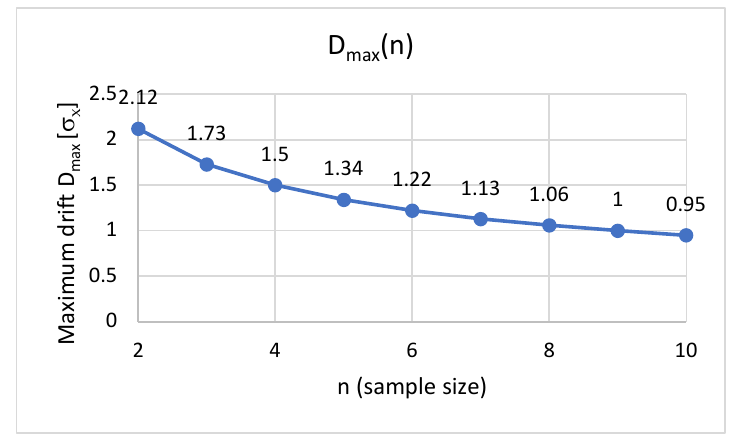
Figure 4. The dependence of the maximum drift on the sample volume n. Relation (2) is used in the same way by Gupta [32], who found the same values. How- the volume of samples used in monitoring the process increases (for example, for n = 4 it is 1.5 σ x , and for n = 9 it decreases to σ x )—Figure